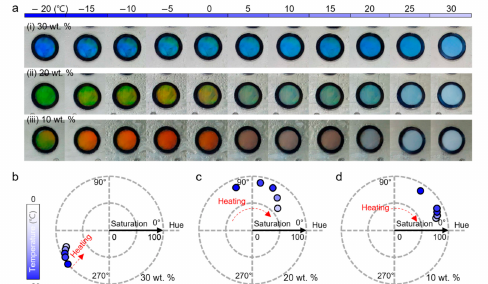
Figure 4. Color response of the ethylene glycol-modulated HPC colorimetric sensor. Photographs showing the HPC colorimetric sensor of ( a ( i )) 30 wt %, ( a ( ii) ) 20 wt.%, and ( a ( iii )) 10 wt % by increase in temperature, respectively. Color response of the colorimetric sensor modulated with ( b ) 30 wt %, ( c ) 20 wt %, and ( d ) 10 wt % as a function of temperature depicted in the HSV color